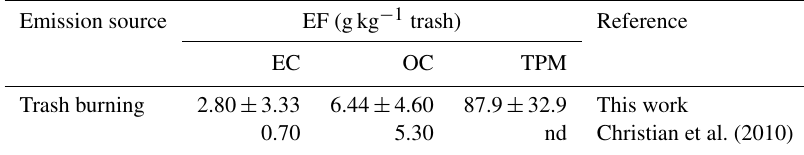
Table 4. EF for open solid trash burning of this study and other studies.